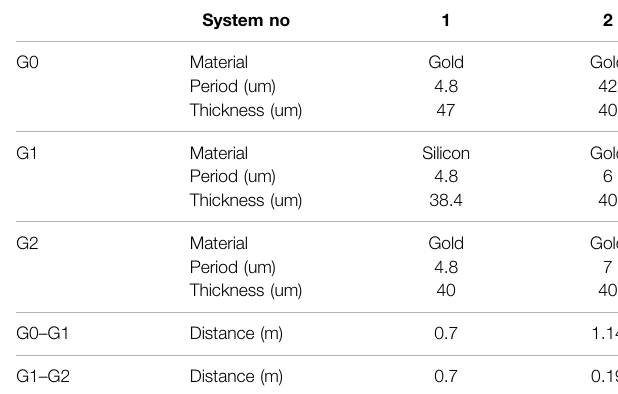
TABLE 1 | System parameters of the simulation and real